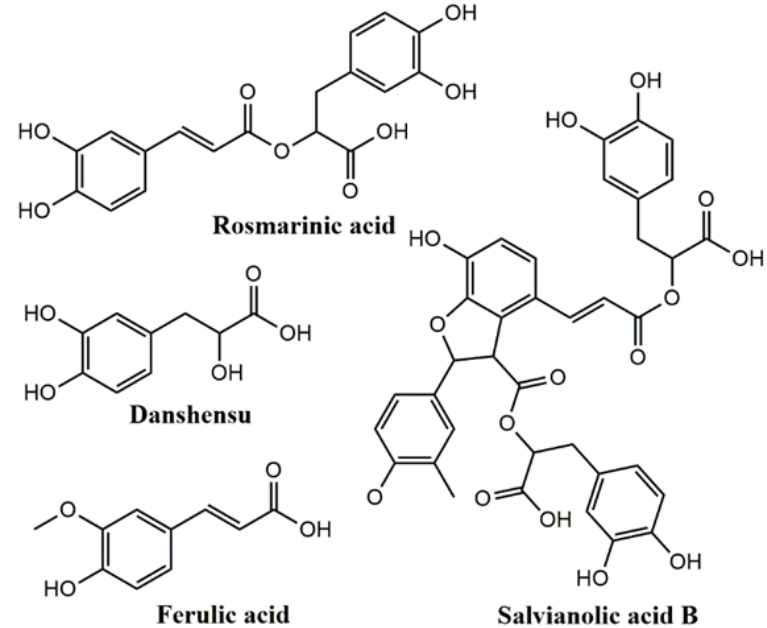
Figure 1. The chemical structures of the four investigated analytes.